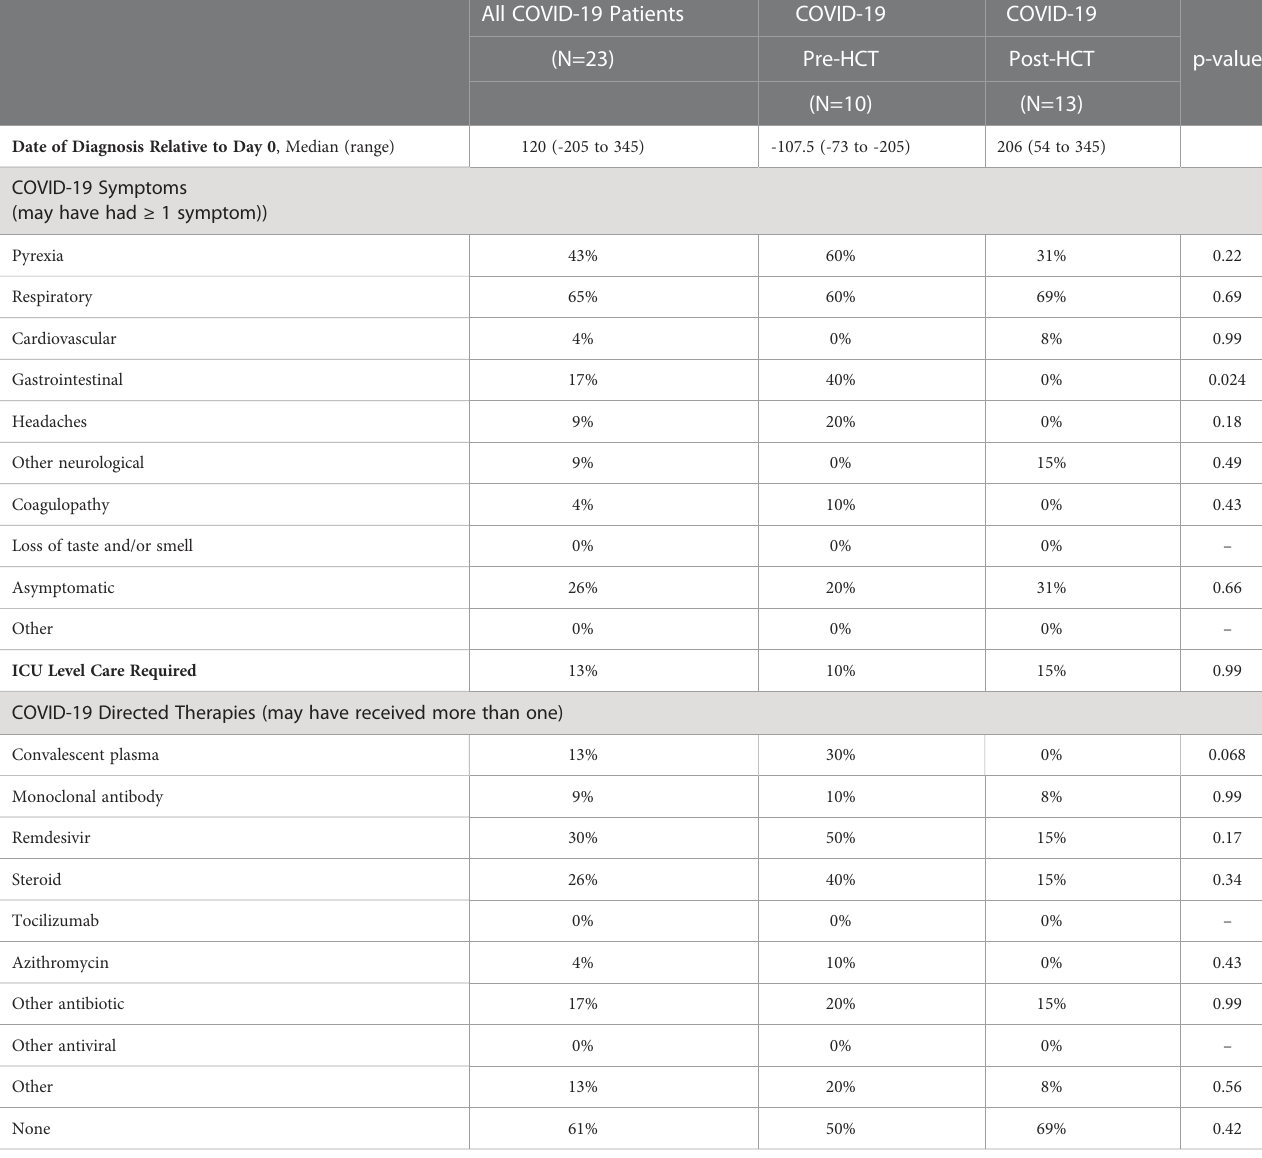
TABLE 2 SARS-Cov-2 infection details among HCT patients who contracted COVID-19 pre- and post-transplant.